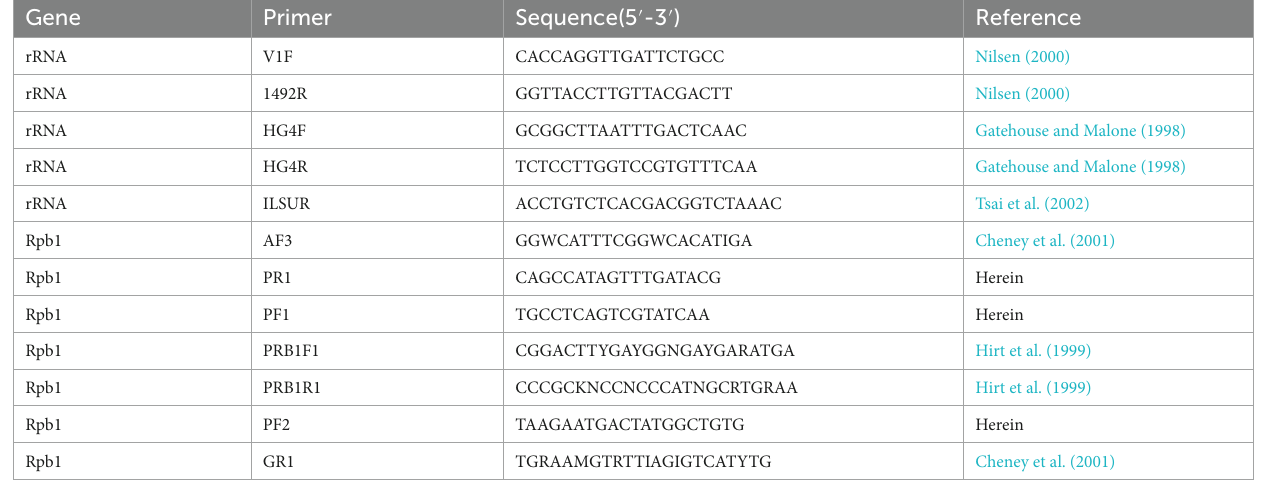
TABLE 1 Primers used for amplifying and sequencing of microsporidia rDNA and Rpb1 genes. Gene